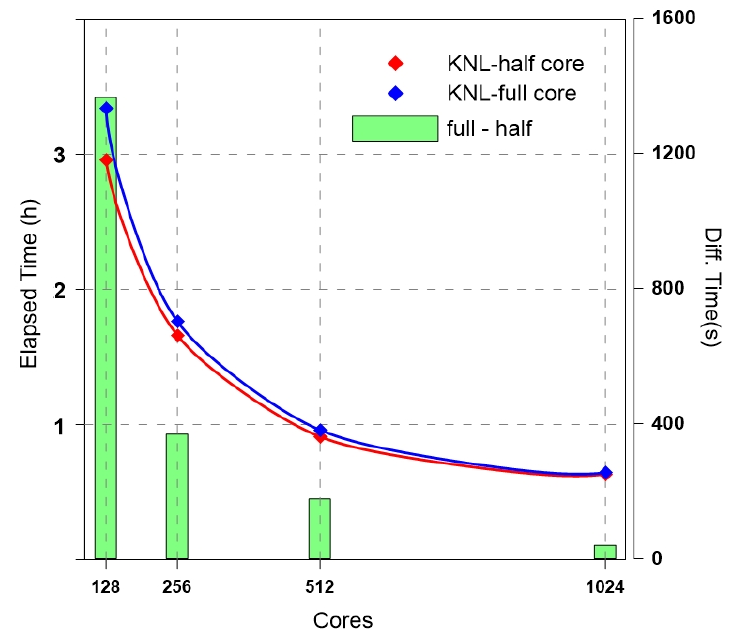
Figure 3. WRF-LES performances with respect to the number of cores per node in the KNL system for an ideal experiment (blue line: 64 cores, red line: 32 cores).